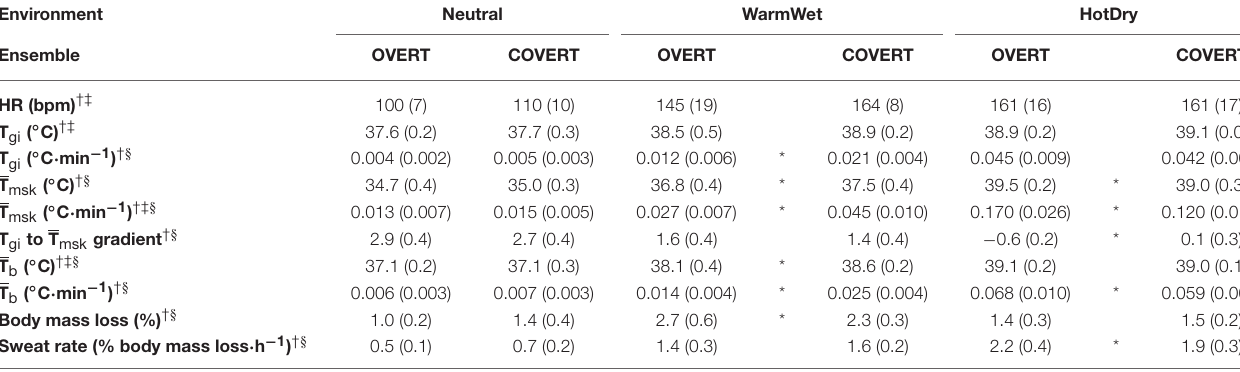
TABLE 4 | Mean (SD) physiological strain at the cessation of trial within each environment and ensemble. Environment Neutral WarmWet HotDry